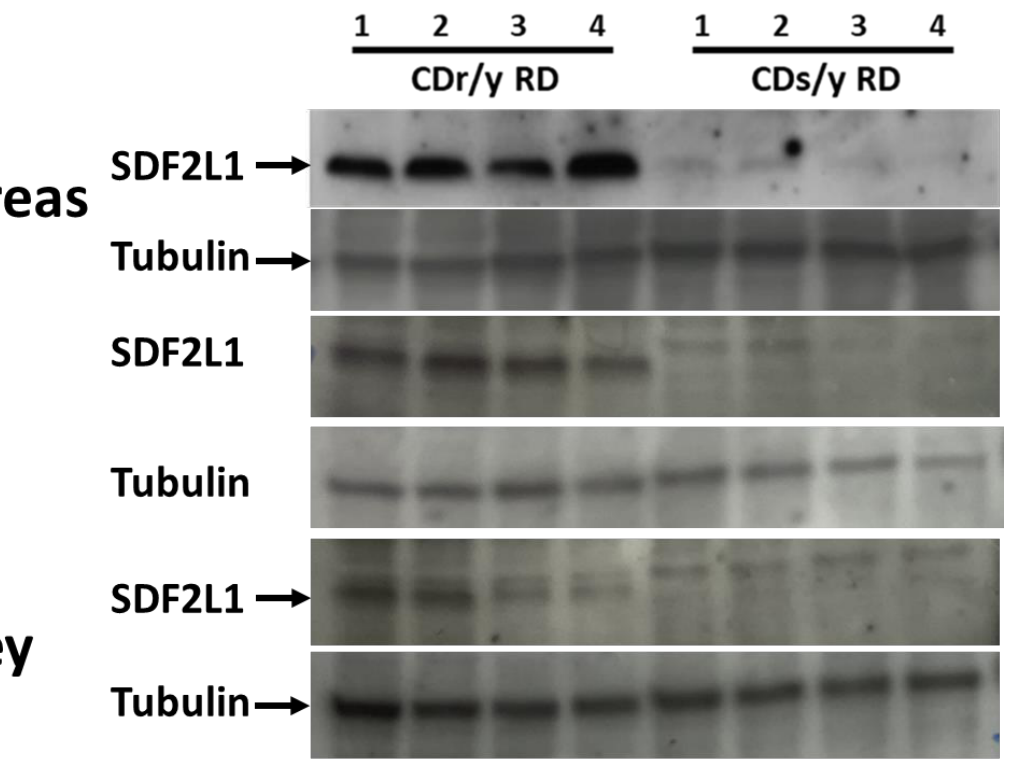
Figure 2. Western blot expression of SDF2L1 (24 kDa) in homogenates of the pancreas, liver, and kidney of CDs/y to CDr/y provided RD. Four separate animals, labeled 1–4, were used for each strain. The reference protein was tubulin (~50 kDa).